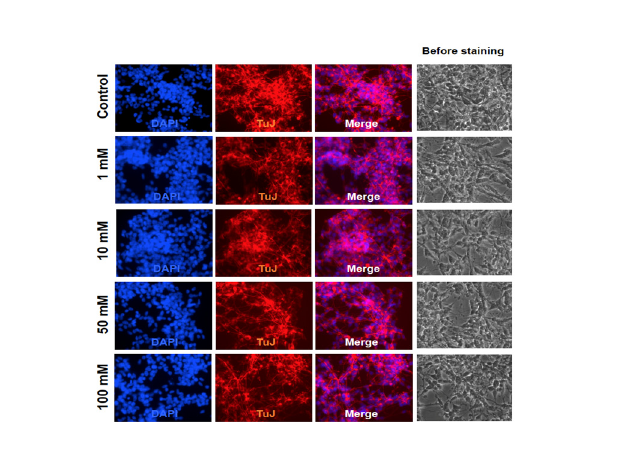
Fig 2. Morphological changes of H1 hESC-derived cortical neurons exposed to ethanol. Morphological changes of H1 hESC-derived cortical neurons exposed to different concentrations of ethanol (0, 1, 10, 50, and 100 mM) were examined by DAPI DNA staining and Tuj1 (antibody specific for neuronal marker beta-III tubulin)